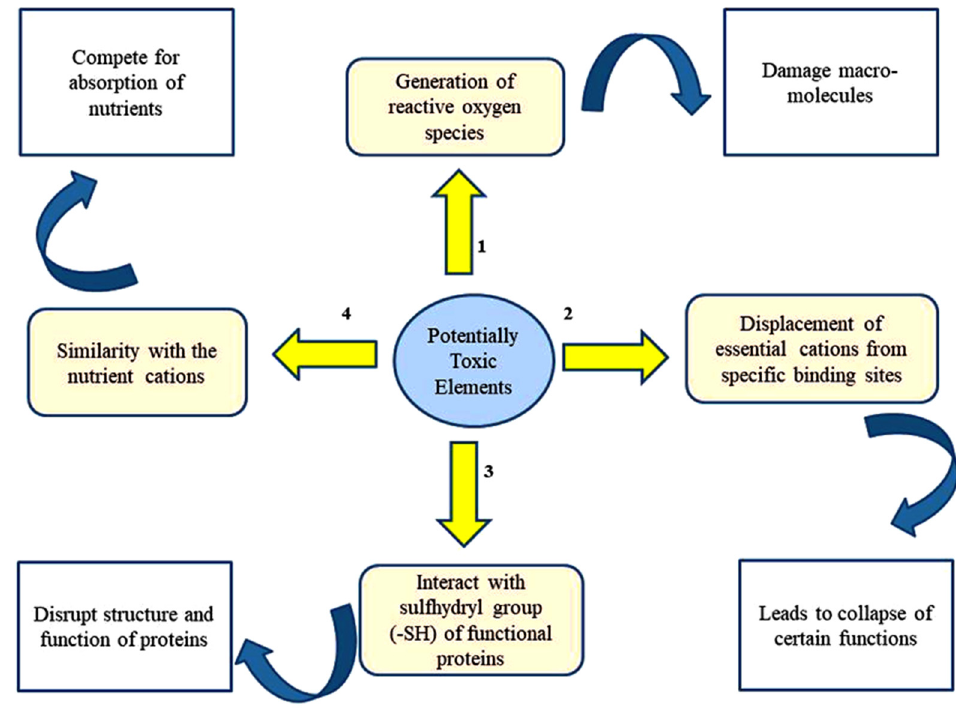
Figure 2. Major mechanisms underlying PTE-caused toxicity in plants.